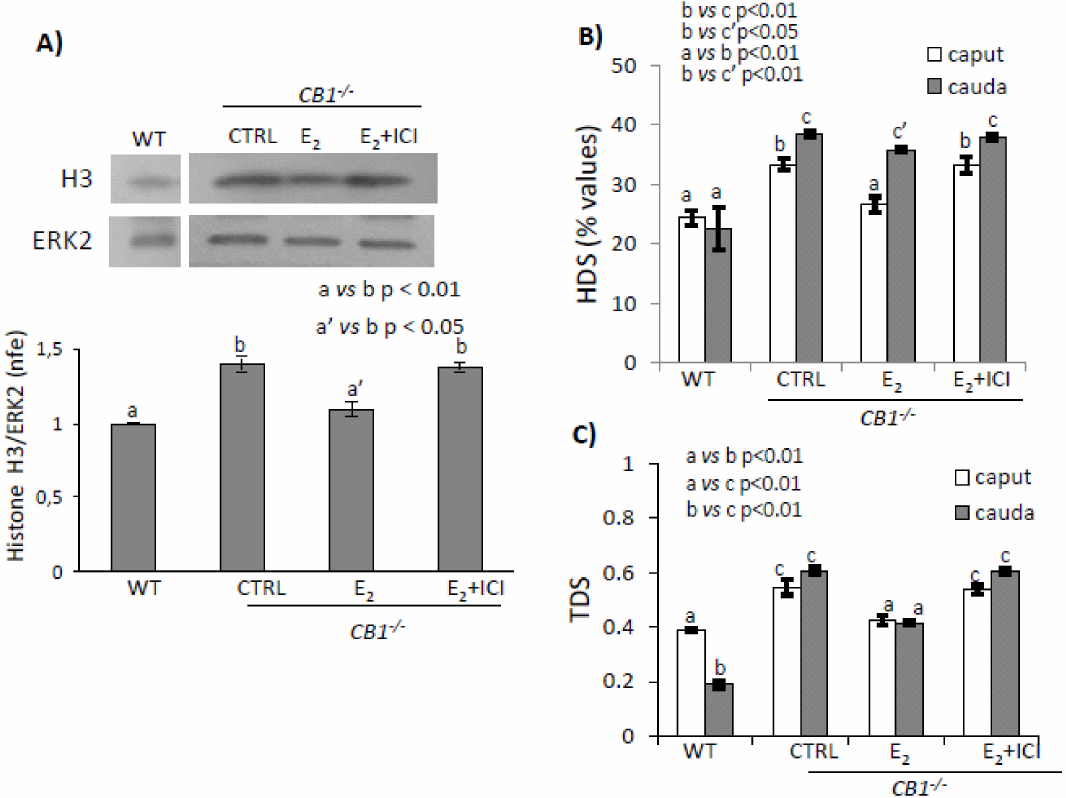
Figure 3. ( A ) Western blot analysis of Histone H3 in testis from WT and CB1 - / - mice in vivo treated with vehicle (CTRL) or E 2 ± ICI. H3 amount was quantified by densitometry analysis, normalized against ERK2 signals, and expressed as a fold change of OD values. Graphs were representative of or four testis / experimental group ( n = 3 or 4 testes from di ff erent animals for each experimental group in triplicates). Flow cytometry analysis of caput and cauda SPZ of CB1 - / - mice in vivo treated with vehicle (CTRL) or E 2 ± ICI. ( B ) HDS (used as index of uncondensed chromatin) and ( C ) TDS (used as index of thiol groups oxidation) values. Graphs were representative of three or four sperm samples / animals / experimental groups ( n = 3 or 4 animals for each experimental group in triplicates). All data are reported as mean values ± S.E.M. Di ff erent letters indicated statistical significance ( p < 0.05 or p < 0.01, a’ vs. a: not